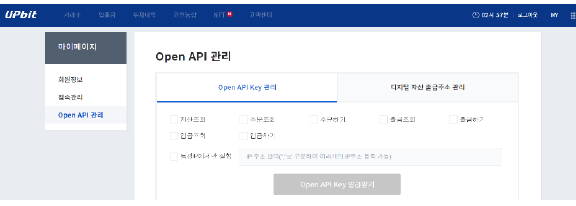
Figure 3. API key issuance screen in Upbit.